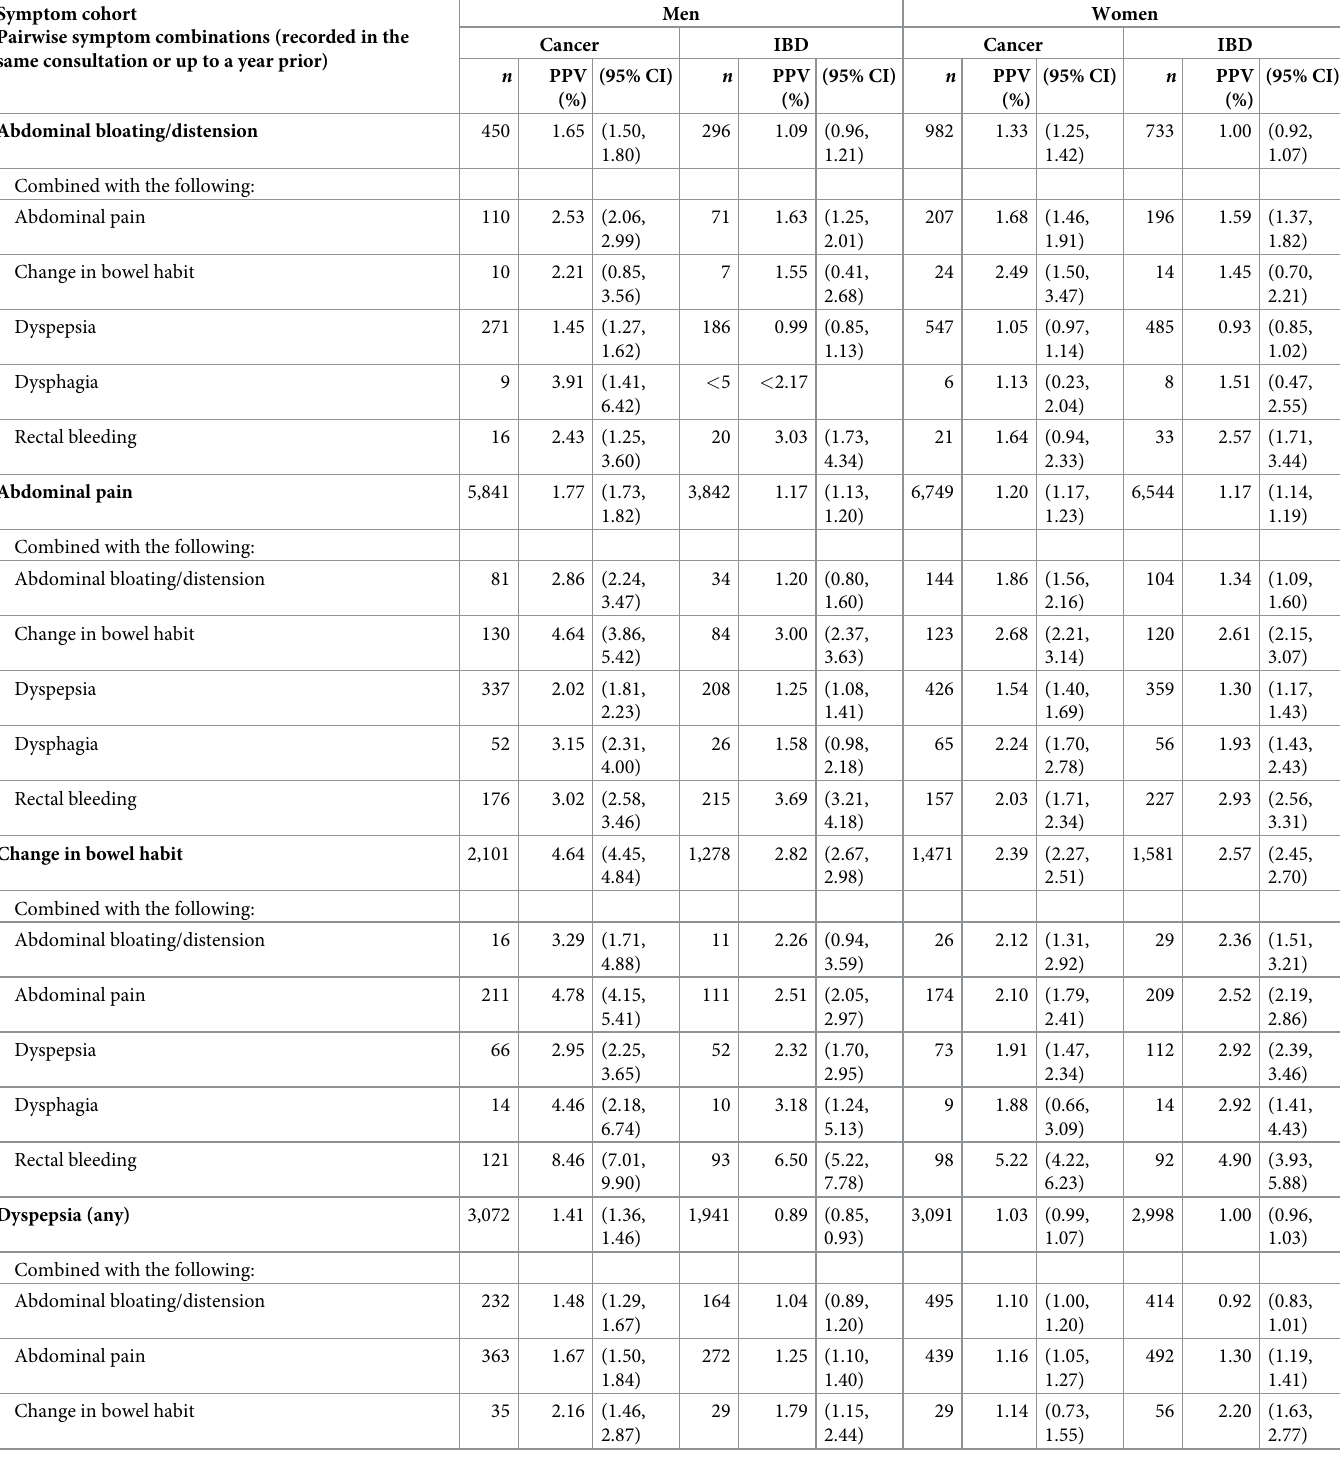
Table 2. Number of incident cases and PPVs (95% CIs) for cancer and for IBD in the year following each studied abdominal symptom, considering each symptom regardless of other symptoms, or in pairwise combinations with the other examined symptoms � . Symptom cohort Pairwise symptom combinations (recorded in the same consultation or up to a year